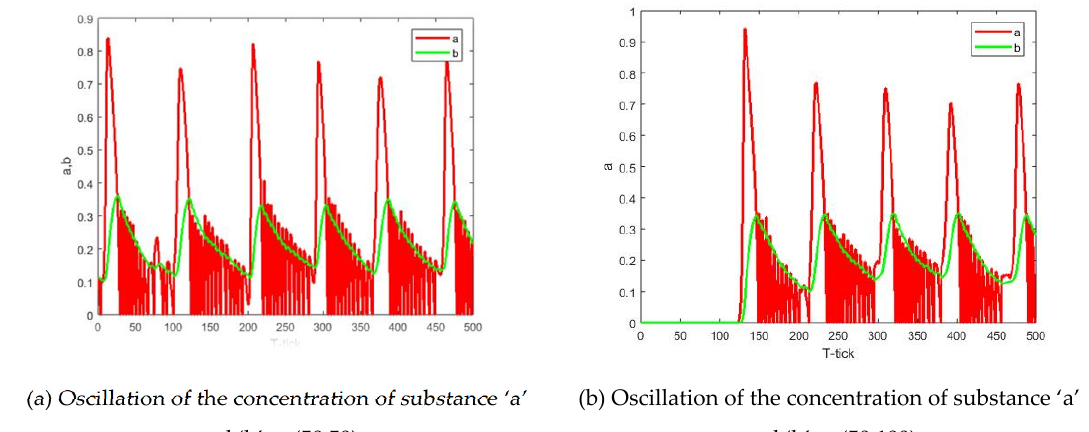
Figure 6. Simulated propagation of target wave for B-Z reaction by partial differential equation (PDE) model.